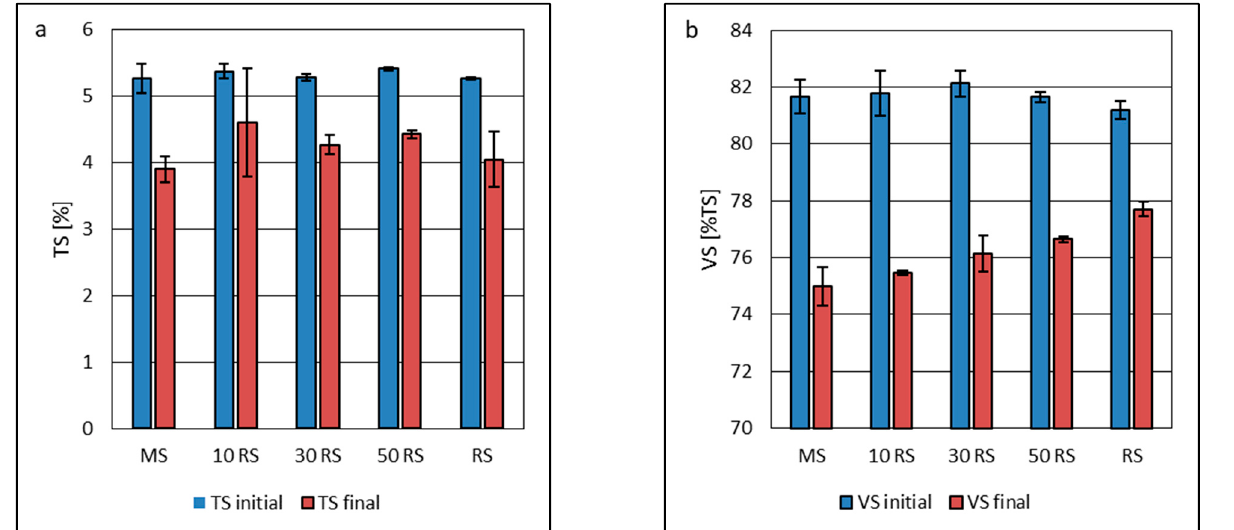
Figure 1. Variations of organics content for co-digestion of maize and reed silage under different combinations: ( a ) TS and ( b ) VS. MS—maize silage, 10 RS—maize silage with 10% content of reed silage, 30 RS—maize silage with 30% content of reed silage, 50 RS—maize silage with 50% content of reed silage and RS—reed silage.